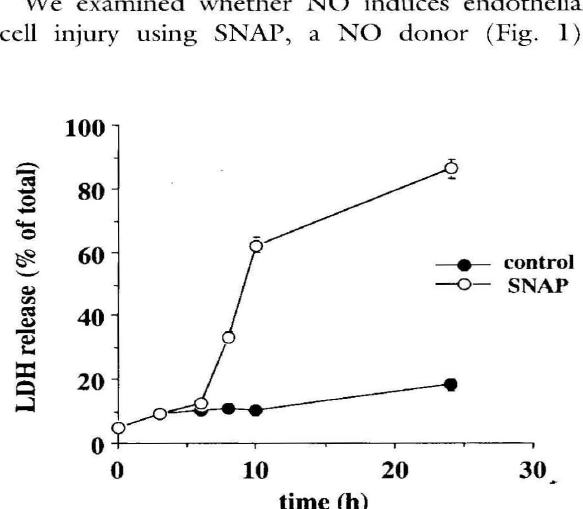
Figure 1. Time course of LDH release from endothelial cells exposed to 2 mM SNAP at 3r C . At the indicated times after addition of SNAP, the percentage of LDH released into the medium was determined. Typical results from 3 experiments are shown as the means ± S.E.M. of quadruplicate